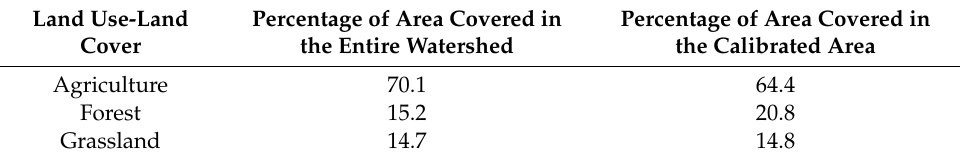
Table 2. Comparison of the basic land use distribution of the entire watershed with the gauged (pre-calibrated) area.